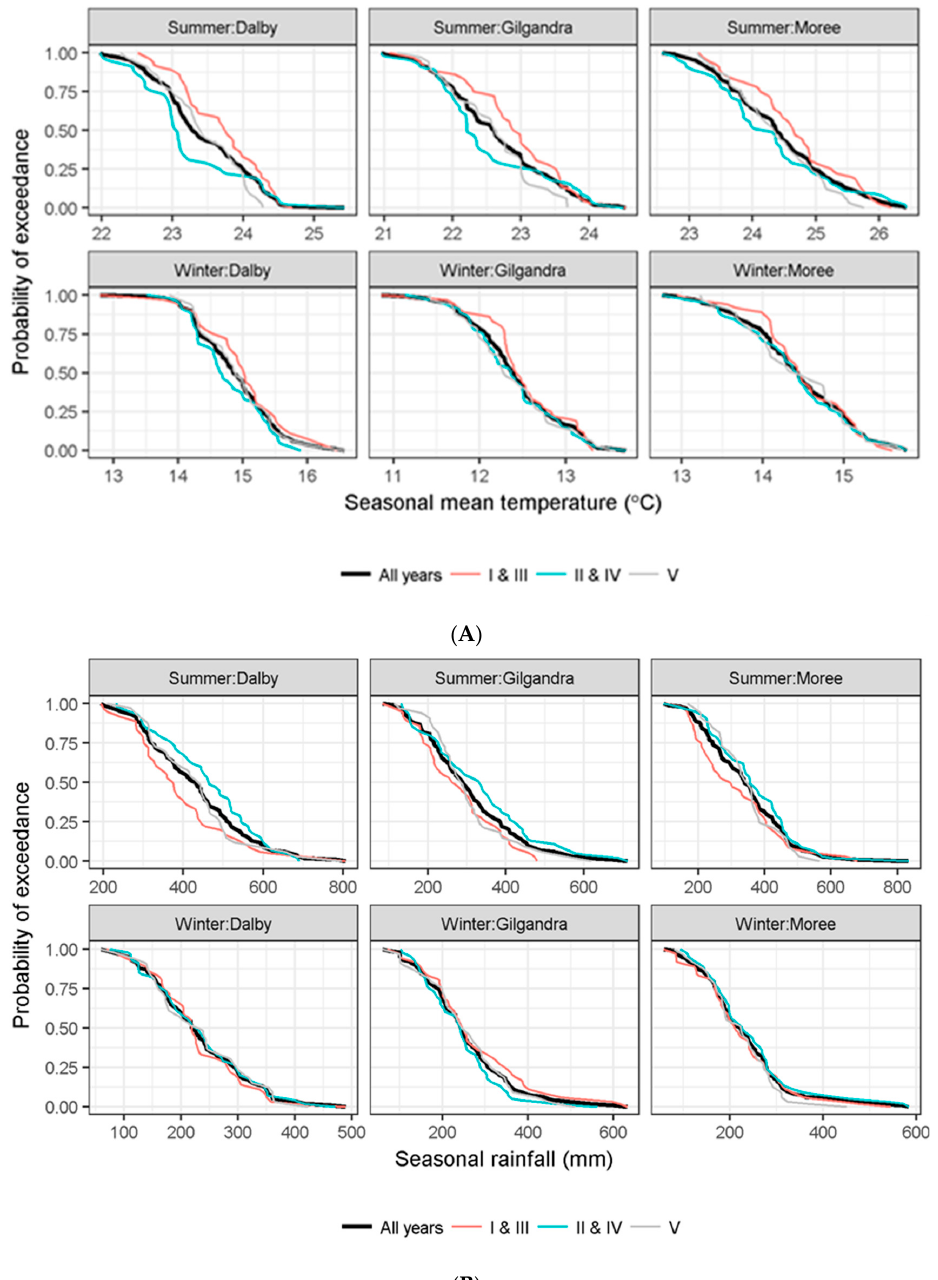
Figure 2. Cumulative probability distributions (probability of exceedance) of ‘summer’ and ‘winter’ average temperature ( A ) and cumulated rainfall ( B ) for the three SOI classes, singly (SOI phases I & III, SOI phases II & IV, and SOI phase V) and combined (‘all years’) for 1900–2016 at three sites in the Eastern wheatbelt. The three SOI classes correspond to SOI consistently negative and rapidly failing (phases I & III), SOI consistently positive and rapidly rising (phases II & IV), and SOI consistently near zero (phase V). SOI phases were determined in March–April, prior to sowing. The ‘summer’ data were recorded from the previous November to April, while ‘winter’ data are for the up ‐ coming May to October period. See Figures S1–S8 for average, minimum and maximum temperature, and cumulated rainfall at other sites for both the ‘summer’ and ‘winter’ periods.